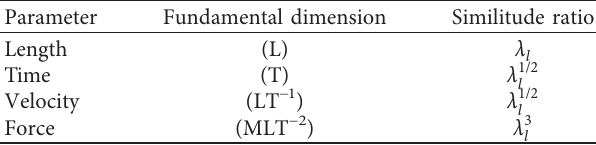
Table 4: Similitude ratios according to the Froude similitude. Parameter Fundamental dimension Similitude